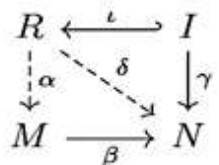
Diagram 13: A ring R is a left pp-ring.